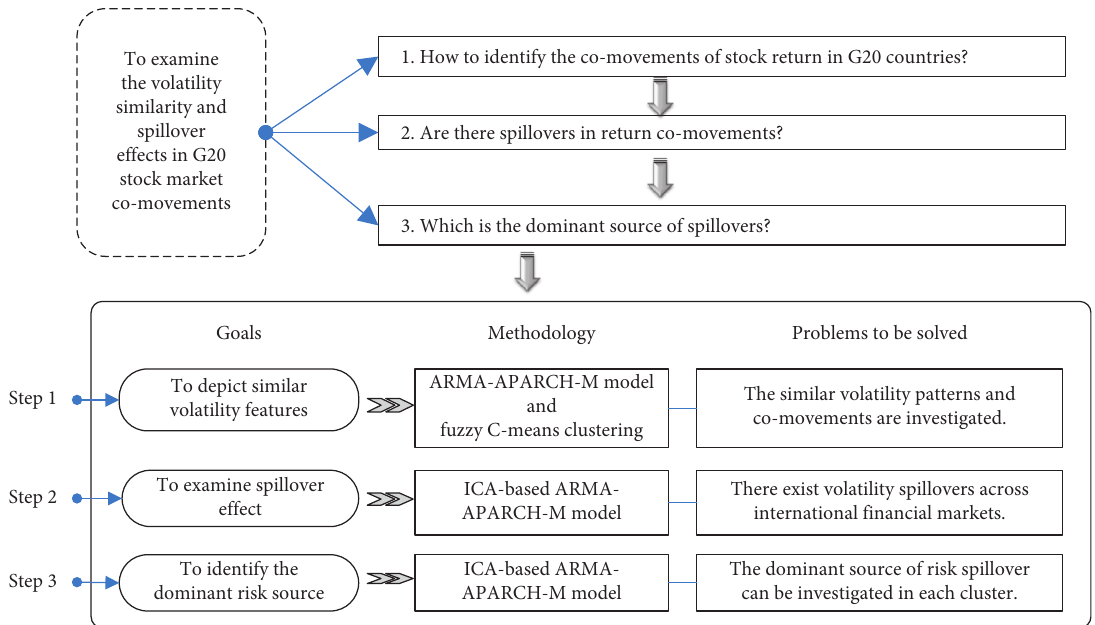
Figure 1: The frame diagram of the